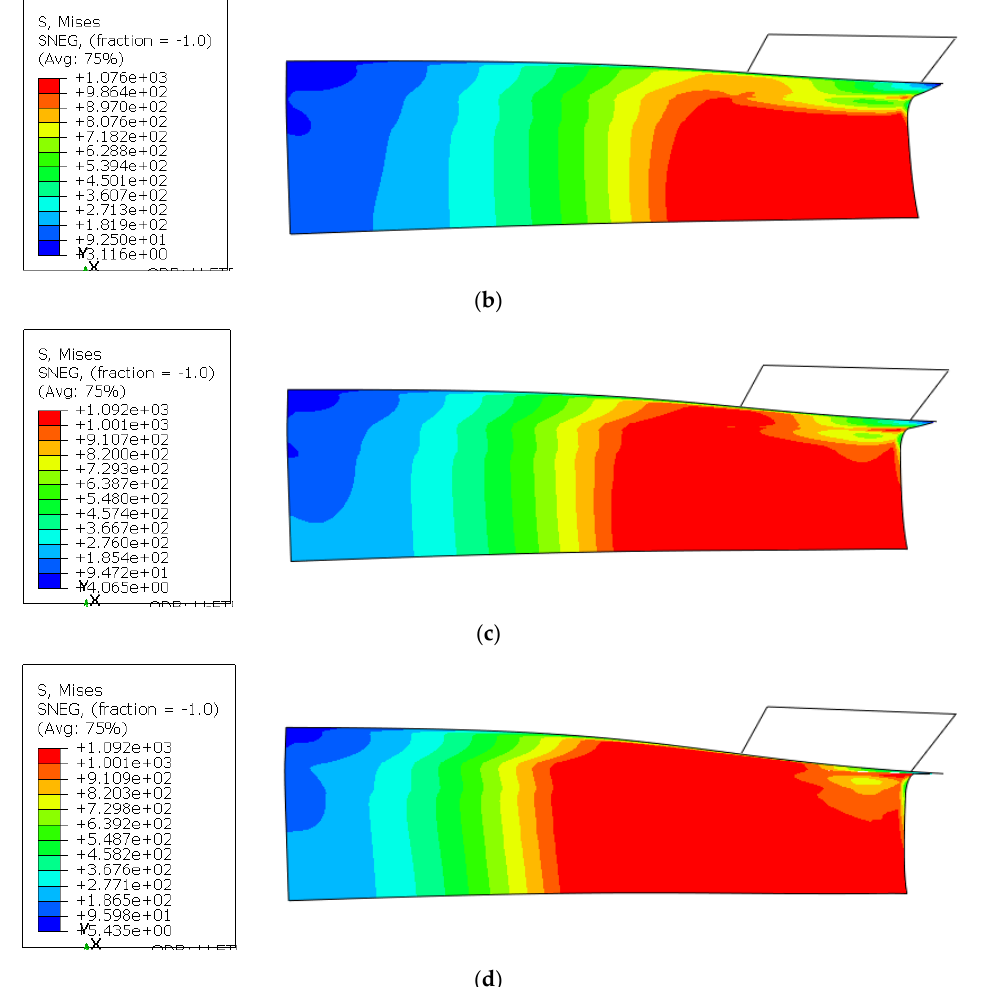
Figure 16. Typical web crippling failure modes of unlipped channel beam under progressive load-